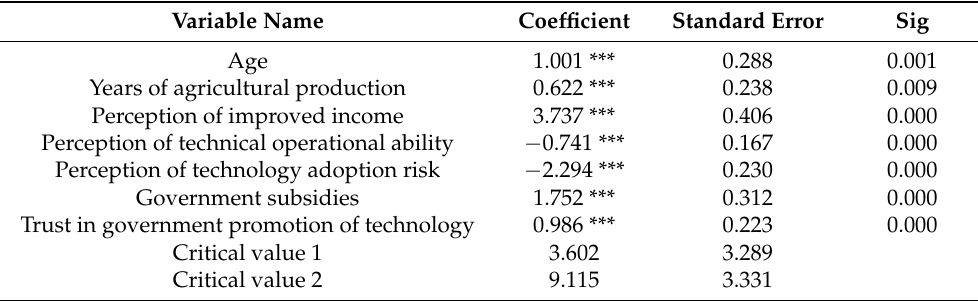
Table 9. Estimation result of farmers’ willingness to adopt insect-proof net